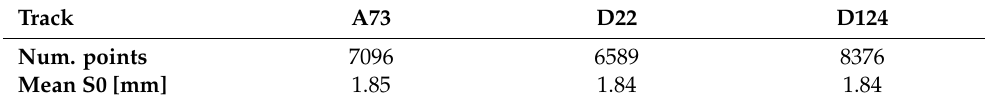
Table 2. Displacement standard deviation (S0 [mm]) of points calculated for individual tracks. Track A73 D22 Num. points Track Mean S0